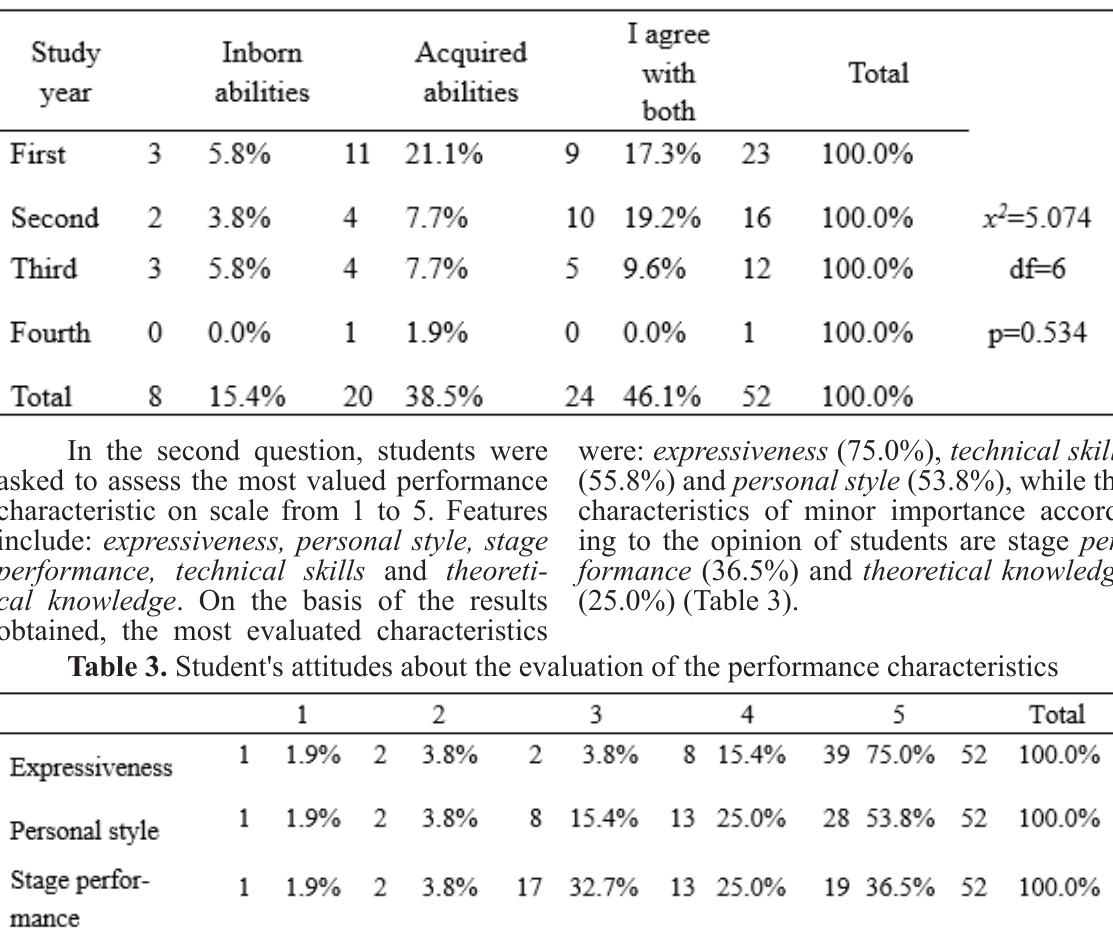
Table 2. Student's attitudes about abilities that influence successful instrumental perfor- mance in relation to the year of